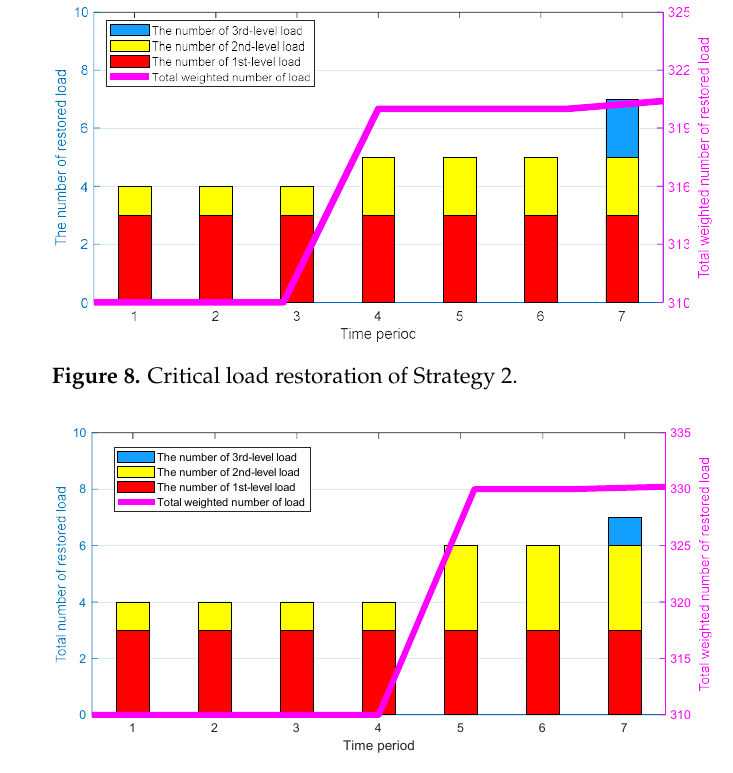
Figure 9. Critical load restoration of Strategy 3. Table 3. Each time period output of each power supply source in the three strategies.